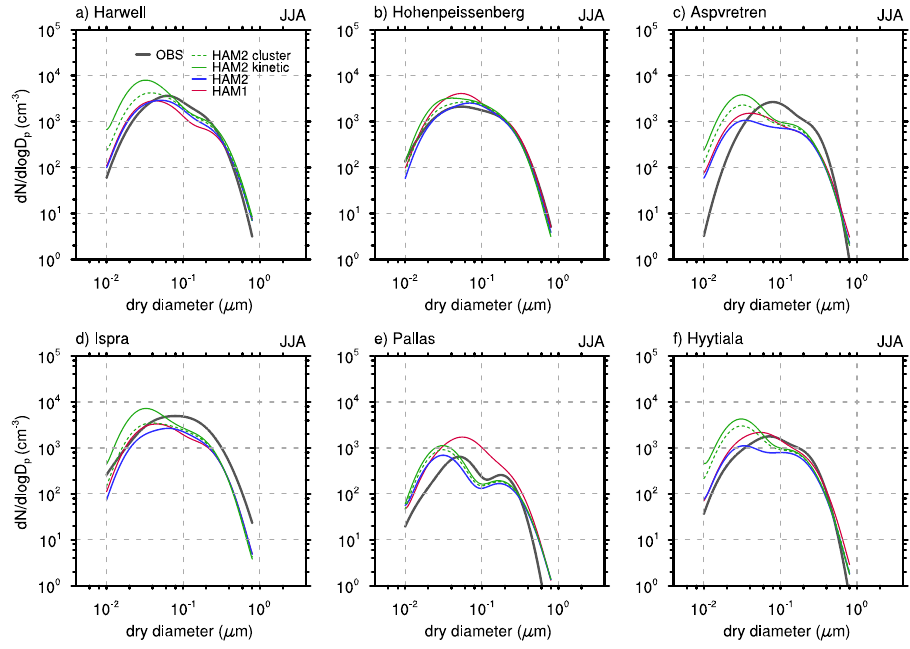
Fig. 15. As in Fig. 14 but for boreal summer